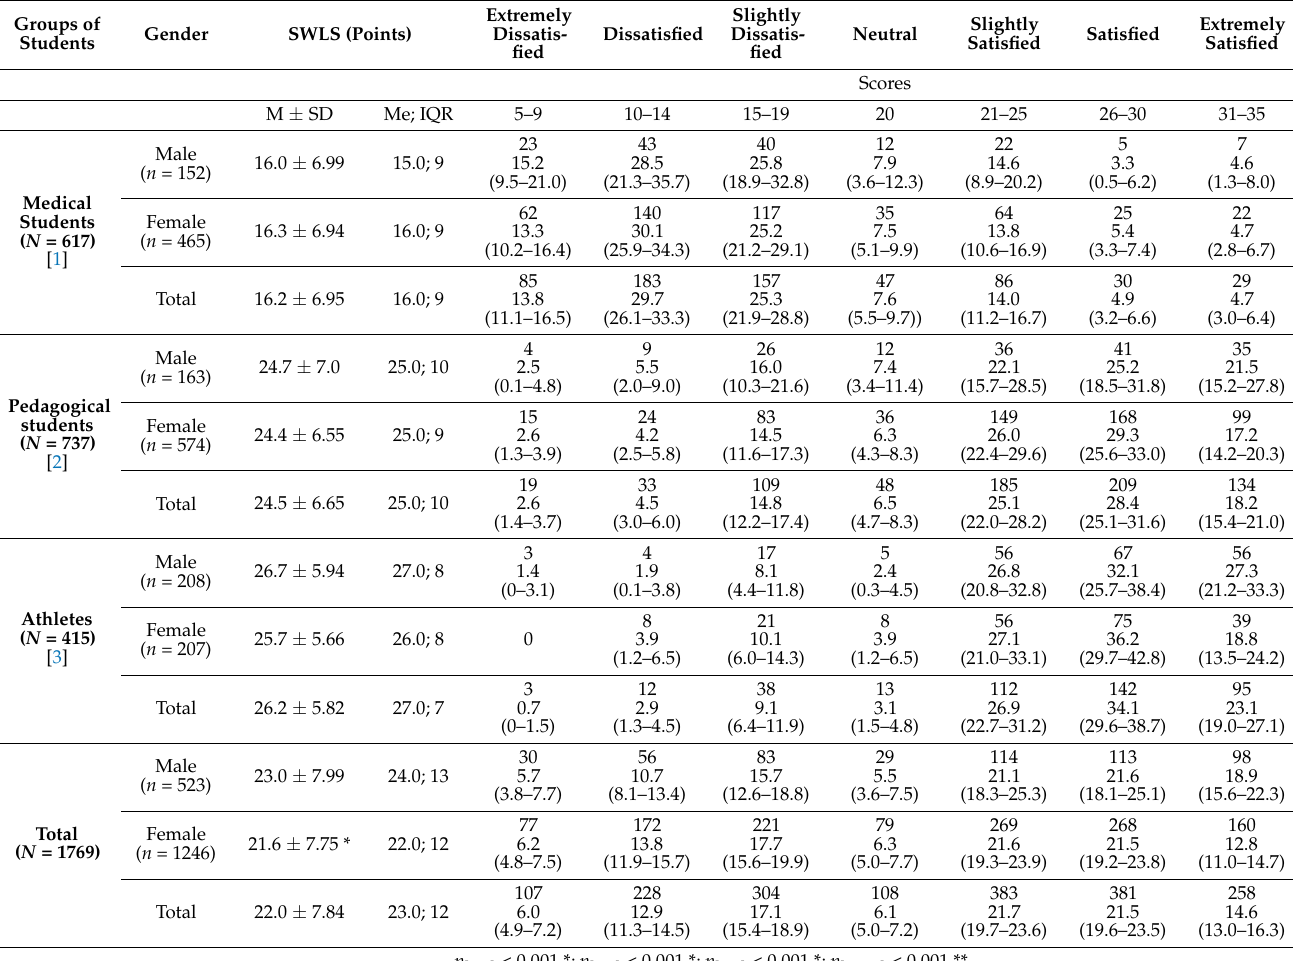
Table 4. SWLS scores for the three groups of students surveyed ( n , %,